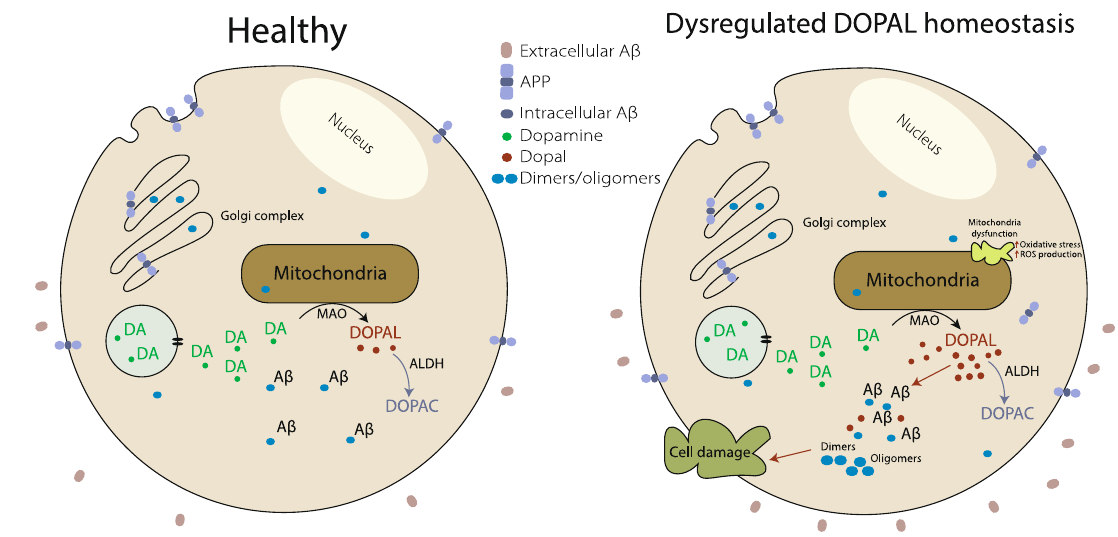
Fig. 6 DOPAL dysregulation hypothesis of A β oligomerisation. A dysregulation in DOPAL homeostasis and a consequent build-up of DOPAL can lead